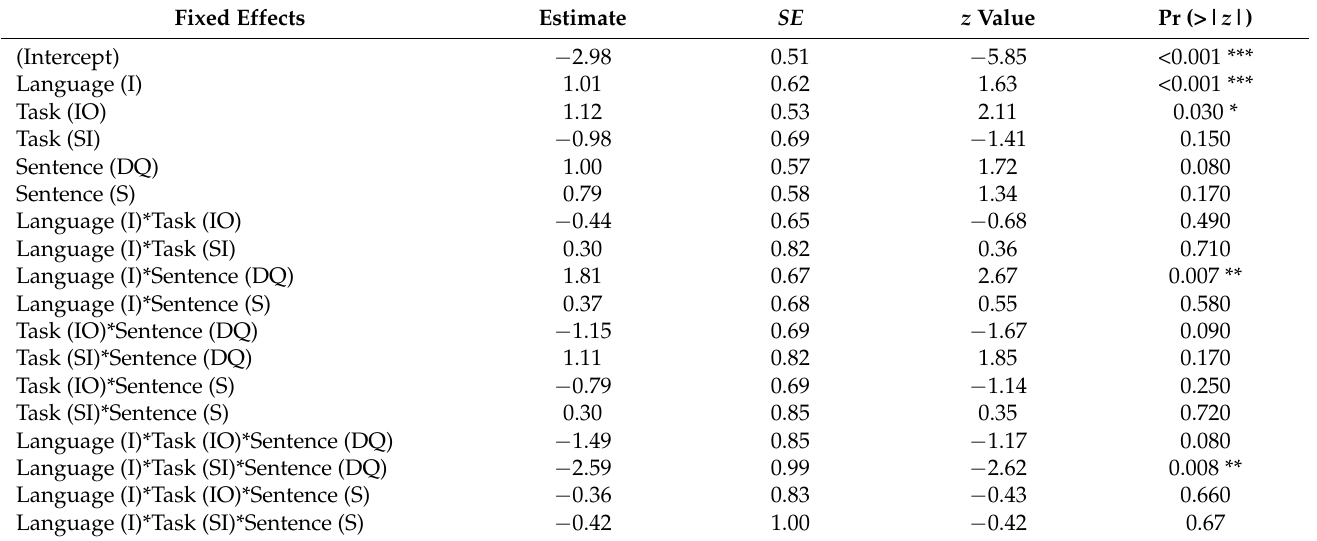
Table 6. Binomial mixed effects model with Language, Task and Sentence Type as fixed effects